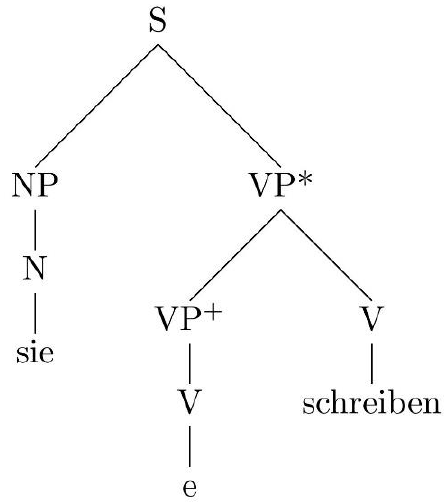
Figure 15. Elementary trees featuring V extraposition